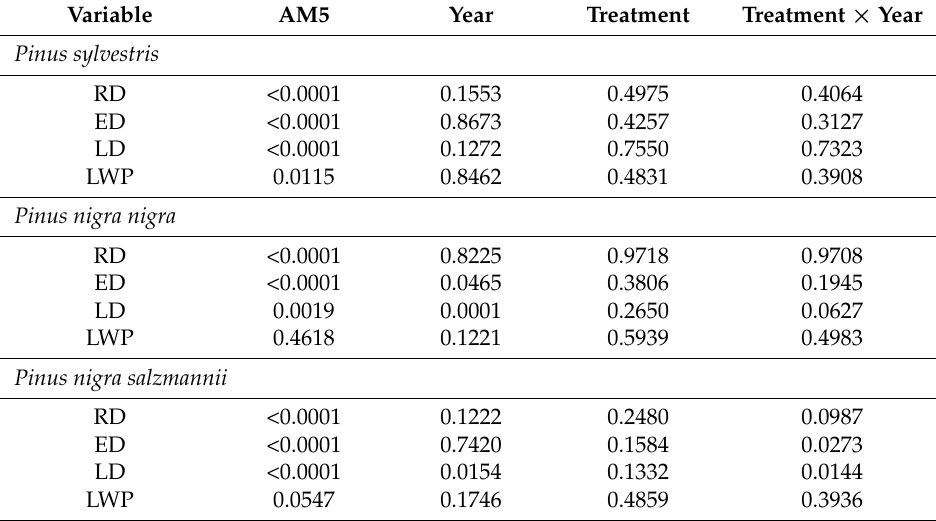
Table 3. p -Values referred to type III sums of squares for the AM5 (5-year arithmetic mean prior to the installation of the trials), Year, Treatment, and Treatment × Year interaction in the RD (ring density), LD (latewood density), ED (earlywood density), and LWP (percentage of latewood)